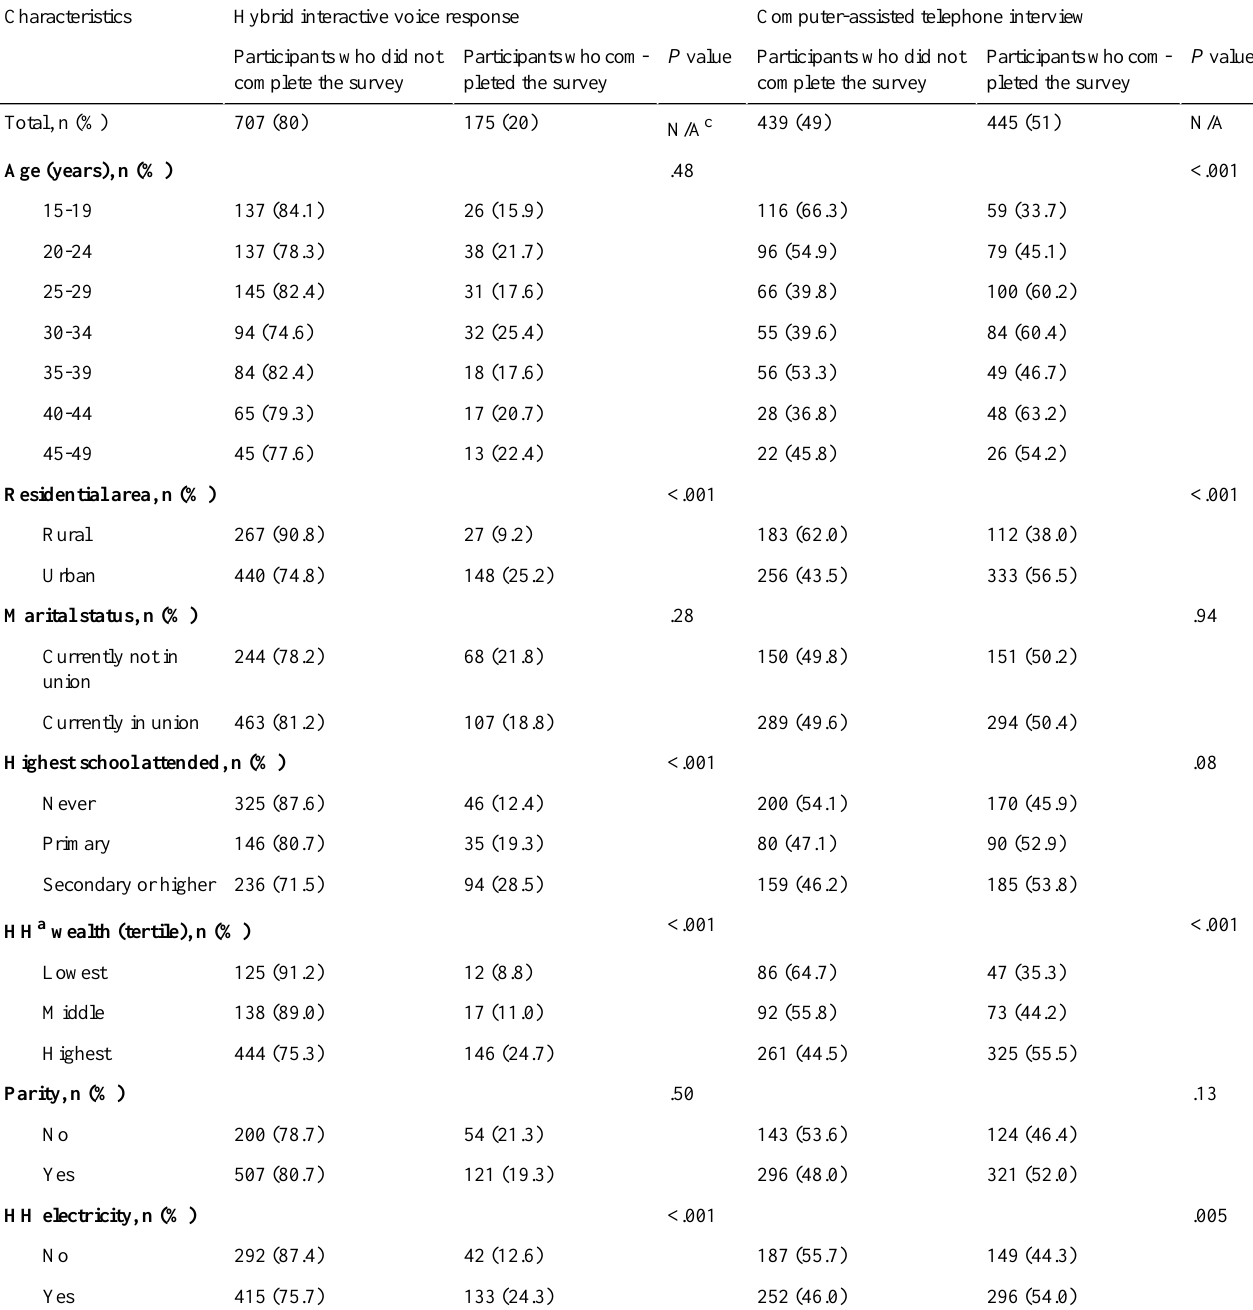
Table 4. Percent completing the hybrid interactive voice response or computer-assisted telephone interview survey by women’s sociodemographic characteristics among female cell phone owners randomized to each